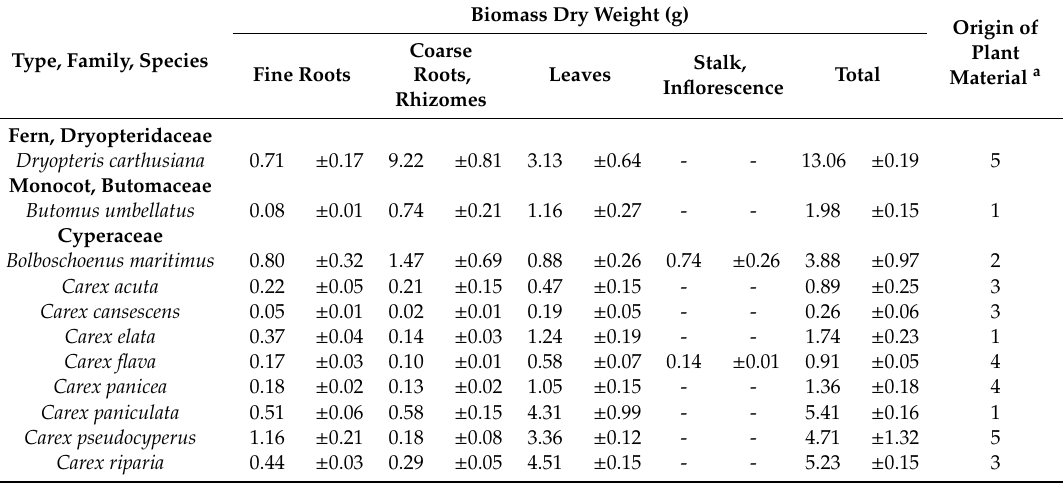
Table 1. Biomass and origin of species included in the experiment. n = 3, ± SE.